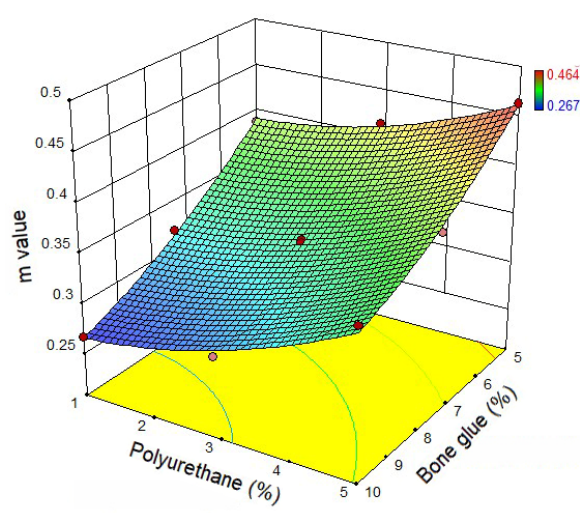
Figure 8. m value of CMA.